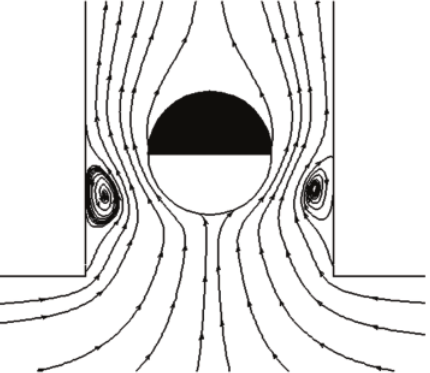
Figure 5: The flow diagram around the Janus cylinder when 𝐸 = 2𝑒5 V / m.